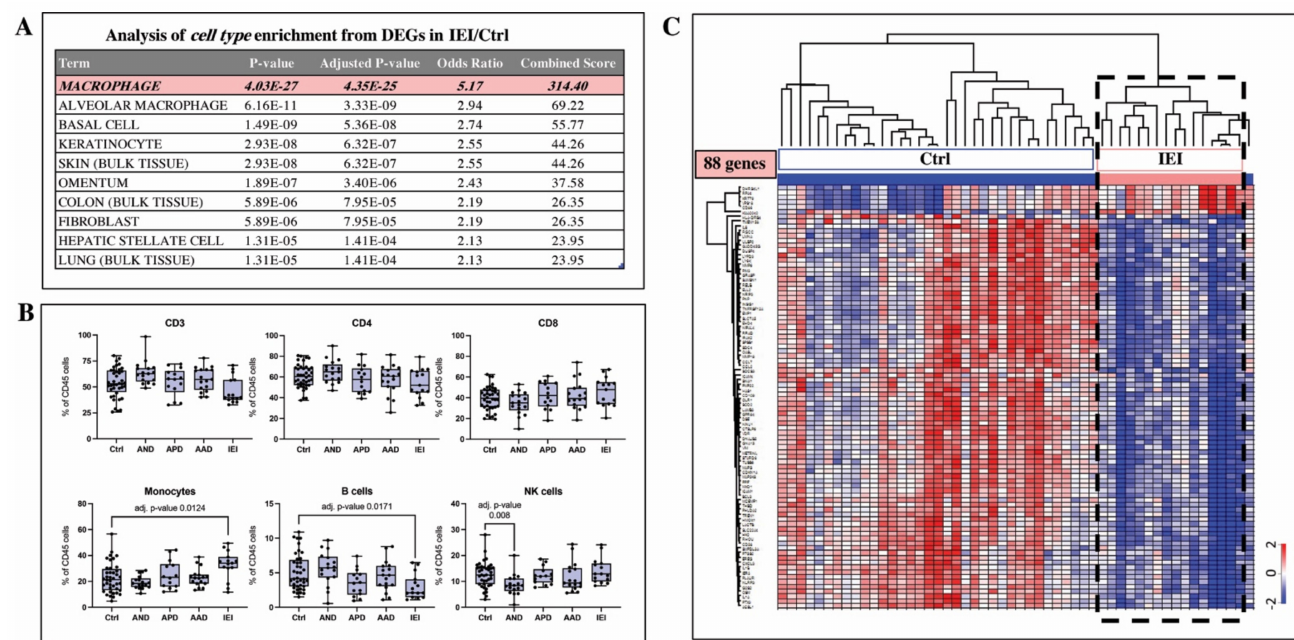
Figure 6. Identified differentially expressed genes (DEGs) in blood cells of idiopathic environmental intolerance ( IEI ) patients relative to controls (Ctrl) were submitted to cell type enrichment analysis. The most significant cell type represented by the expression signature of these genes were macrophages ( A ). The relative expression of 88 genes identified to be differentially expressed between IEI patients and controls was consistent with genes enriched in RNA-seq expression profiles (1716 samples) of macrophages in ARCHS database (overlapping not shown). Cell type enrichment analysis was also performed via FACS analysis. Significantly elevated levels of monocytes were observed in IEI subjects’ blood. Patient groups with asthma that is associated to dampness and molds, possibly associated to dampness and molds, and not associated with dampness and molds are denoted as AAD (n = 16), APD (n = 17), and AND (n = 17), respectively. Patients diagnosed with idiopathic environmental intolerance are denoted as IEI (n = 16) and controls are denoted as Ctrl (n = 21). Analysis was performed using the Kruskal–Wallis test with Dunn’s post-hoc correction ( B ). Despite having elevated monocyte levels, macrophage signature genes were found to be predominantly downregulated in the blood cells of individuals diagnosed with IEI. A heatmap showing the relative expression (z-score normalized) of these genes in control and IEI blood cell samples is shown in ( C ). Controls comprise individuals who did not take any inhaled corticosteroid (n = 21) plus a subset of controls that used inhaled corticosteroid for 4 weeks (n = 14). The dashed bold rectangle highlights a cluster of IEI patients with downregulated expression of these macrophage-associated